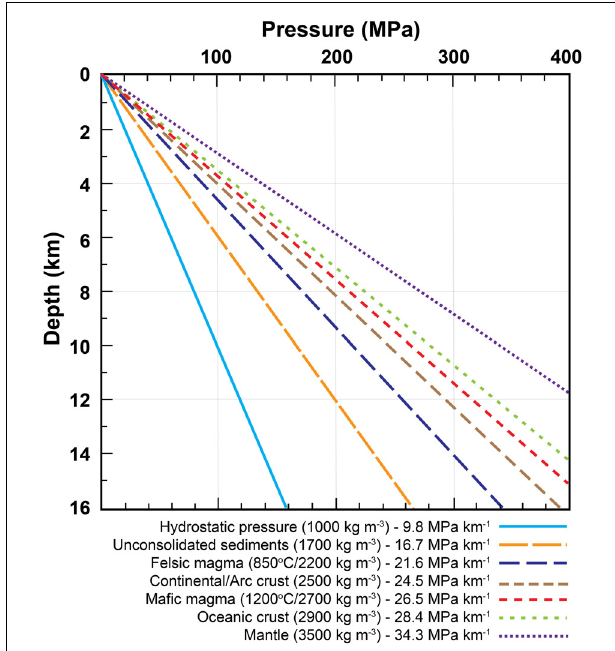
FIGURE 1 | Pressure gradients for water (hydrostatic), magma (magmastatic), various crust types, and the mantle